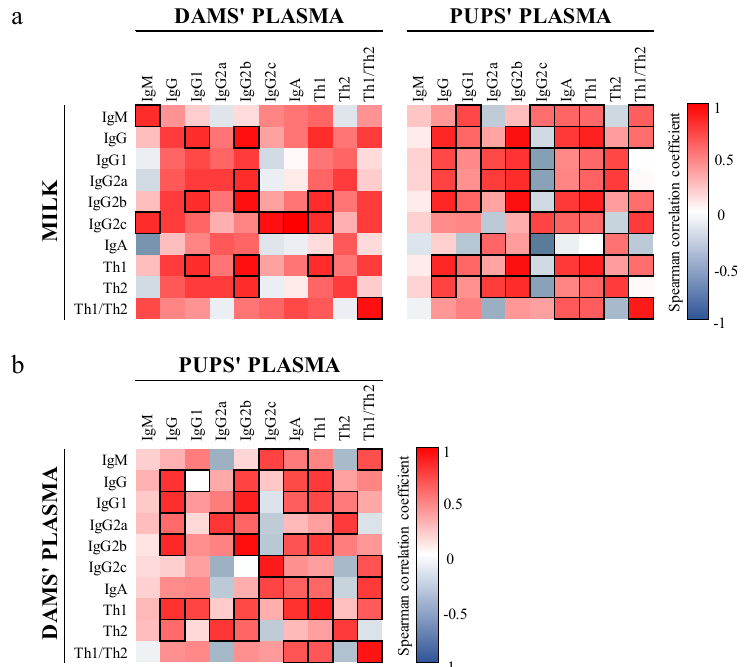
Figure 3. Correlation between the Ig composition of milk, dams’ plasma, and pups’ plasma. ( a ) Correlation between milk and dams’ and pups’ plasma and ( b ) correlation between dams’ and pups’ plasma. The Spearman correlation coefficient is represented in the heat map following the color in the legend. Correlations with statistical significance ( p < 0.05) are shown in a bold frame. Results derived from n = 6 for milk and dams’ plasma and n = 16 for pups’ plasma.